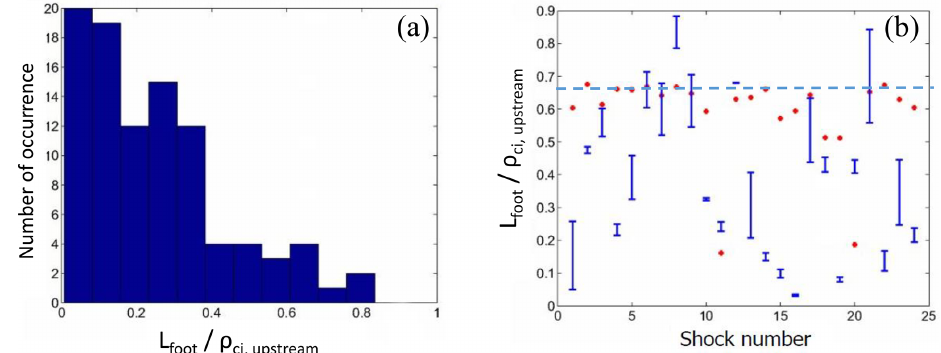
Figure 10. (a) Distribution of the 96 shock crossings versus the foot thickness (normalized versus the upstream ion gyroradius ρ ci , upstream ). (b) Distribution of the largest experimental foot thickness (normalized versus the upstream ion gyroradius ρ ci , upstream ) for every shock event; the vertical bars correspond to the error estimate made on the measured values in blue, and the red dots correspond to the upper-bound values, i.e., the theoretical values obtained from Eqs. (1)–(3) of Sect. 4.3 (Eq. 3 of Gosling and Robson, 1985). For reference, the value = 90 ◦ (Woods, 1971) is indicated by the light blue horizontal dashed line in (b) . L foot /ρ ci , upstream = 0 . 68 defined for θ B n